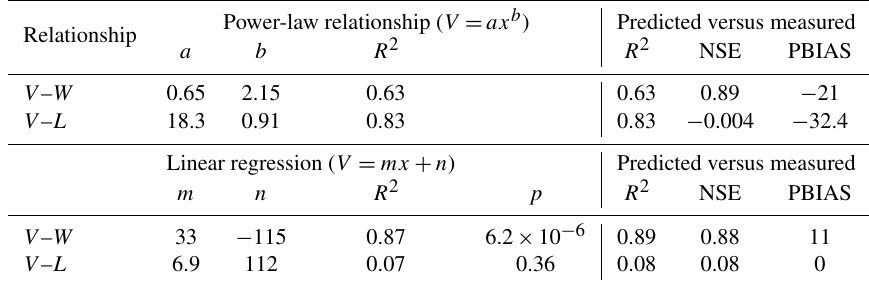
Table 5. Relationships of the volumetric gully headcut erosion ( V ) with the headward migration length ( L ) and the lateral erosion ( W ) during the 2013 rain phase for the 13 gullies in the Debre Mawi watershed. The observed gully volumes were fitted as functions of L or W using power-law and linear regression models. V – W and V – L refer to V as a function of W or L , respectively.